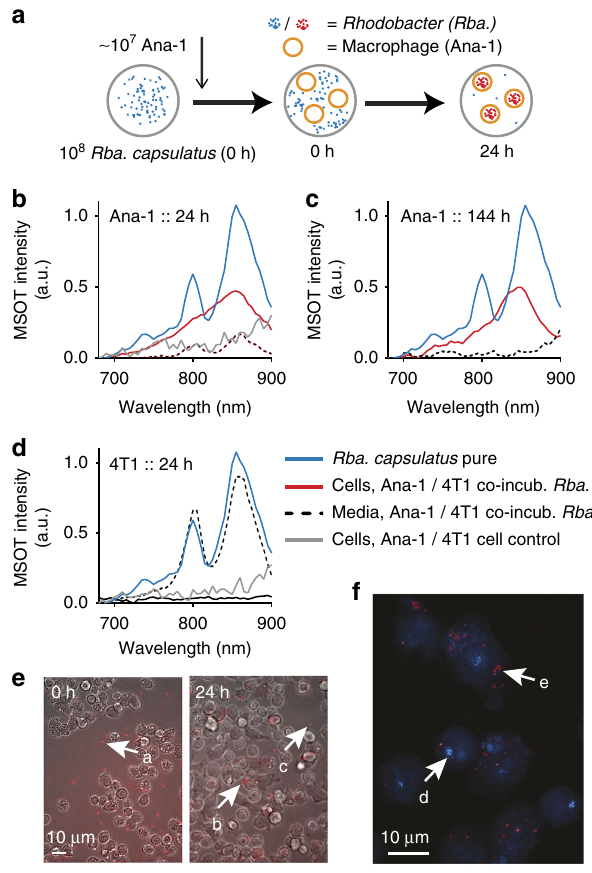
Fig. 2 Addition of Rba . capsulatus SB1003 to Ana-1 macrophages and 4T1 tumor cells in vitro. Bacteria and mammalian cells were co-incubated at a ratio of 50:1, this being the maximum number of bacteria that can be taken up by one phagocyte. a Schematic of Rhodobacter getting ingested by macrophages resulting in a spectral shift as indicated by the blue and red coloration. b , c OA spectra of Ana-1 cells and supernatant after 24 and 144 h of co-incubation with Rba. capsulatus in comparison with the spectra of pure Rhodobacter . d 24 h data for 4T1 cells. e Representative images of Ana- 1 macrophages in the presence of Rhodobacter at 0 and 24 h. After mixing bacterial and macrophage cells free swimming Rhodobacter (a) can be observed, while after 24 h the signal originates predominantly from inside the Ana-1 cells (b) with only a small number of bacteria identi fi able outside (c). For 0 h fl uorescence was recorded with a mCherry fi lter set, for 24 h with Cy7. Because of the high motility of Rhodobacter cells, fl uorescence and bright fi eld images do not overlay. The full time course can be found in Supplementary Figure 10. f Fixated sample stained for lysosomal marker Lamp-1 (d, blue) and additionally recorded with Cy7 fi lter set for fl uorescence of disintegrated Rhodobacter (e). Images for the individual channels as well as for the control, Ana-1 without addition of Rba ., can be found in Supplementary Figure 11. All scale bars 10 µ